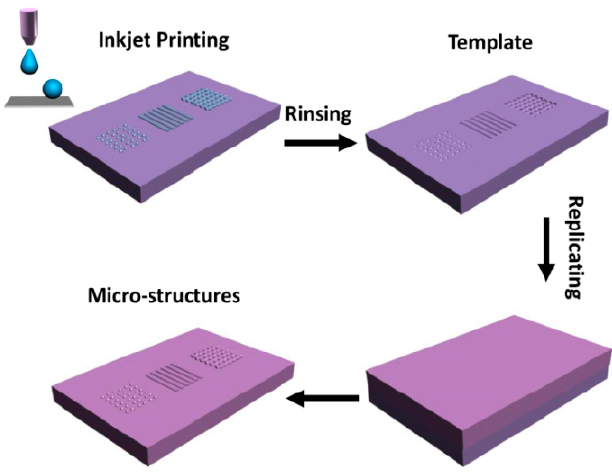
Figure 1. Scheme of fabricating microstructured surface based on etched templates by inkjet printing technology.